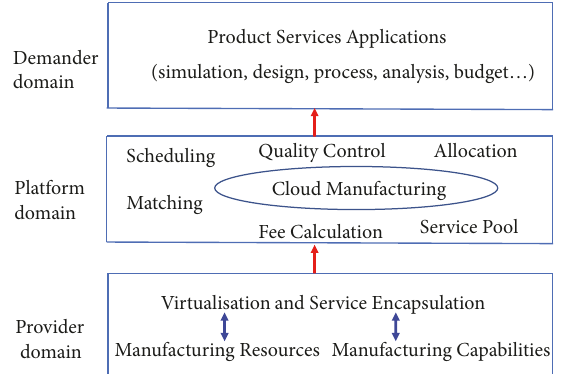
Figure 1: Cloud manufacturing architecture, adapted from [1, 5,